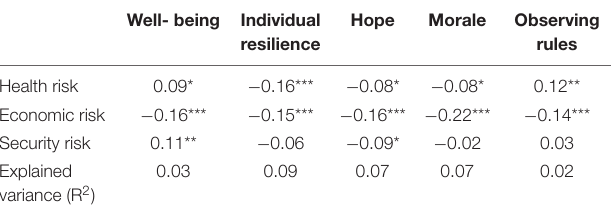
TABLE 3 | Standardized estimates of path analyses for three perceived risks predicting five beneficial reactions. Well- being Individual